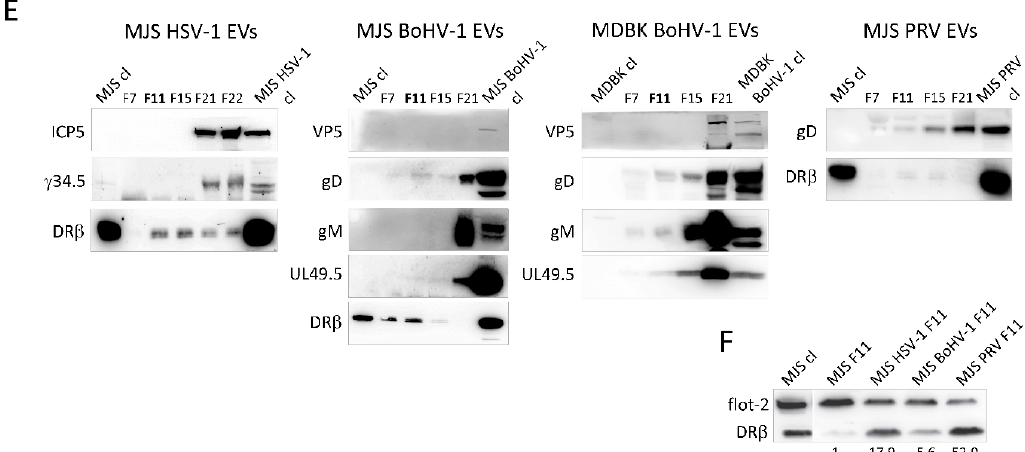
Figure 7. Alphaherpesvirus gB localizes to EVs-enriched fractions isolated from virus-infected MJS cells and BoHV-1-infected MDBK. OptiPrep gradient-purification of EVs-enriched and virion-enriched fractions from HSV-1-infected MJS ( A ), BoHV-1-infected MJS ( B ), PRV-infected MJS ( C ), and BoHV-1-infected MDBK ( D ) supernatants. MJS cells were infected with HSV-1 at a multiplicity of infection (moi) of 0.1, with BoHV-1 / PRV at an moi of 0.5; MDBK cells were infected at an moi of 0.1. After 50 h post-infection, 0.5 mL fractions were collected from 6%–18% iodixanol (Optiprep) gradient by ultracentrifugation. The 40 µ L samples were analyzed in denaturing (for viral glycoprotein C-gC, glycoprotein B-gB, glycoprotein D-gD, for HSV-1, glycoprotein E-gE, for BoHV-1 and PRV or EVs marker Alix) or non-denaturing (for EVs markers CD63 and CD9) SDS-PAGE, and immunoblotted with specific mAbs or polyclonal anti-PRV gB serum. Uninfected (Ø) or virus-infected cell lysates (cl) were analyzed as controls. Bottom panels represent virus titres in each fraction measured by plaque assay. ( E ) Proteins from the indicated fractions (40 µ L) were separated by SDS-PAGE, and immunoblotted with antibodies specific to the ICP5 / VCP5 homolog of HSV-1 and BoHV-1, virulence factor γ 34.5 from HSV-1, immunomodulatory UL49.5 protein of BoHV-1 and envelope glycoproteins gD, and gM, as indicated. HLA-DR β was detected in the fractions as an EVs marker. Cell lysates (cl) and virus-infected cell lysates (30 µ g) were analyzed as controls. ( F ) Comparison of HLA-DR β levels between EVs from virus-infected and uninfected MJS. DR β and flotillin-2 (flot-2, EVs marker) from F11 fractions were immunoblotted with specific mAb. Numbers indicate the optical density of DR β bands from virus-infected MJS EVs, normalized to flot-2 from the same samples, relative to DR β in EVs from uninfected MJS (set as 1).